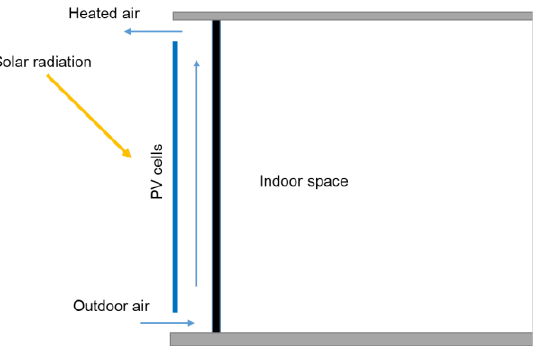
Figure 15. Scheme of ventilated passive PV facade.